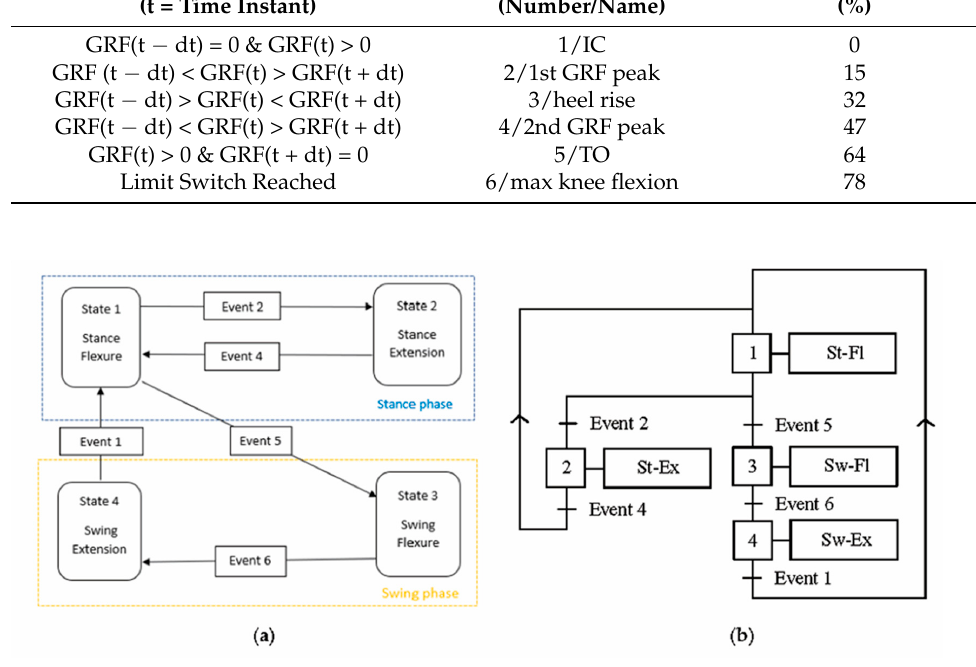
Figure 7. Modeling of the prosthesis control scheme: ( a ) finite-state machine and ( b ) sequential functional chart (St: stance; Sw: swing; Fl: flexure; Ex: extension).